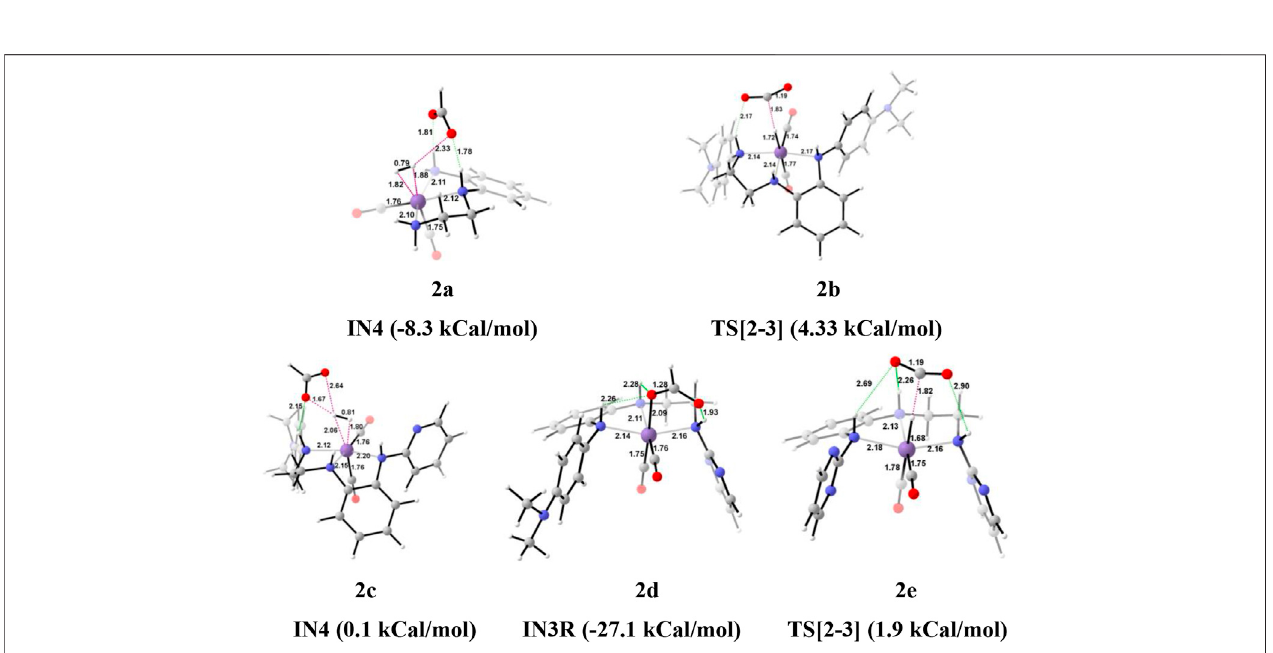
FIGURE9| The optimized geometries ofthetransitionstate intheformationofformic acidfromcarbon dioxideforcatalysts 2a – 2e .ThebondlengthsareinÅ,and relative Gibbs free energies are in parentheses (Figures are shown in Supplementary Data Sheet S1 for all the optimized geometries of all the transition states and